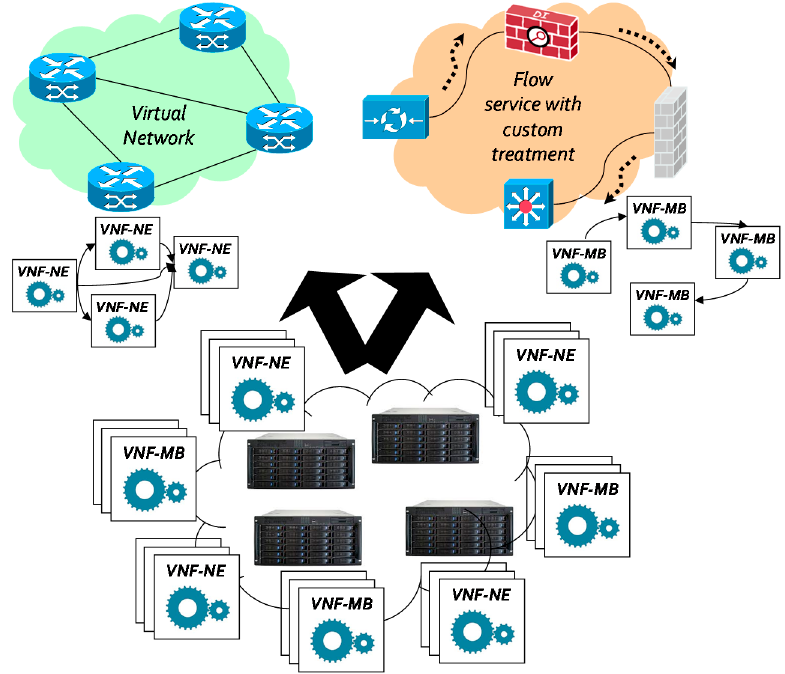
Figure 1. Scenarios for dynamic composition of Virtual Network Functions.